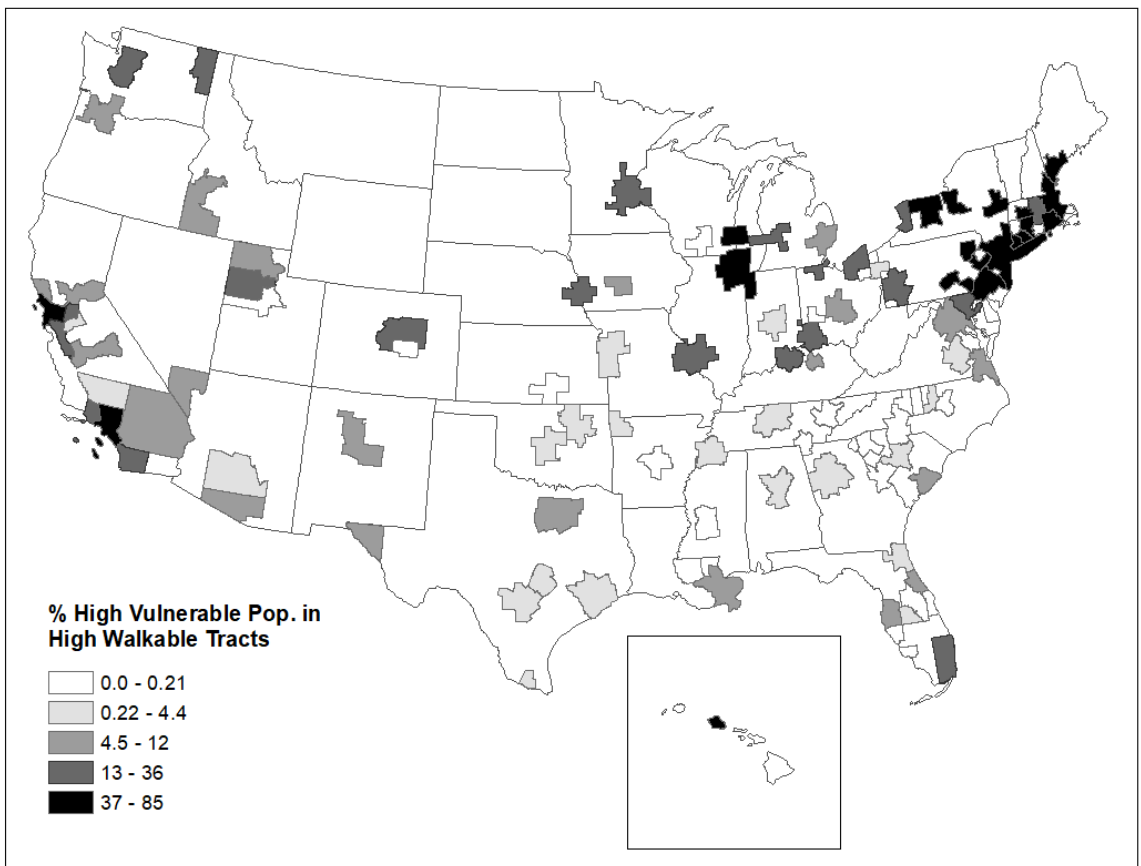
Figure 3. Percentage of urban population residing in high (80th percentile) socially vulnerable (SV) census tracts also residing within highly walkable (walk score ≥ 70) census tracts by metropolitan area.